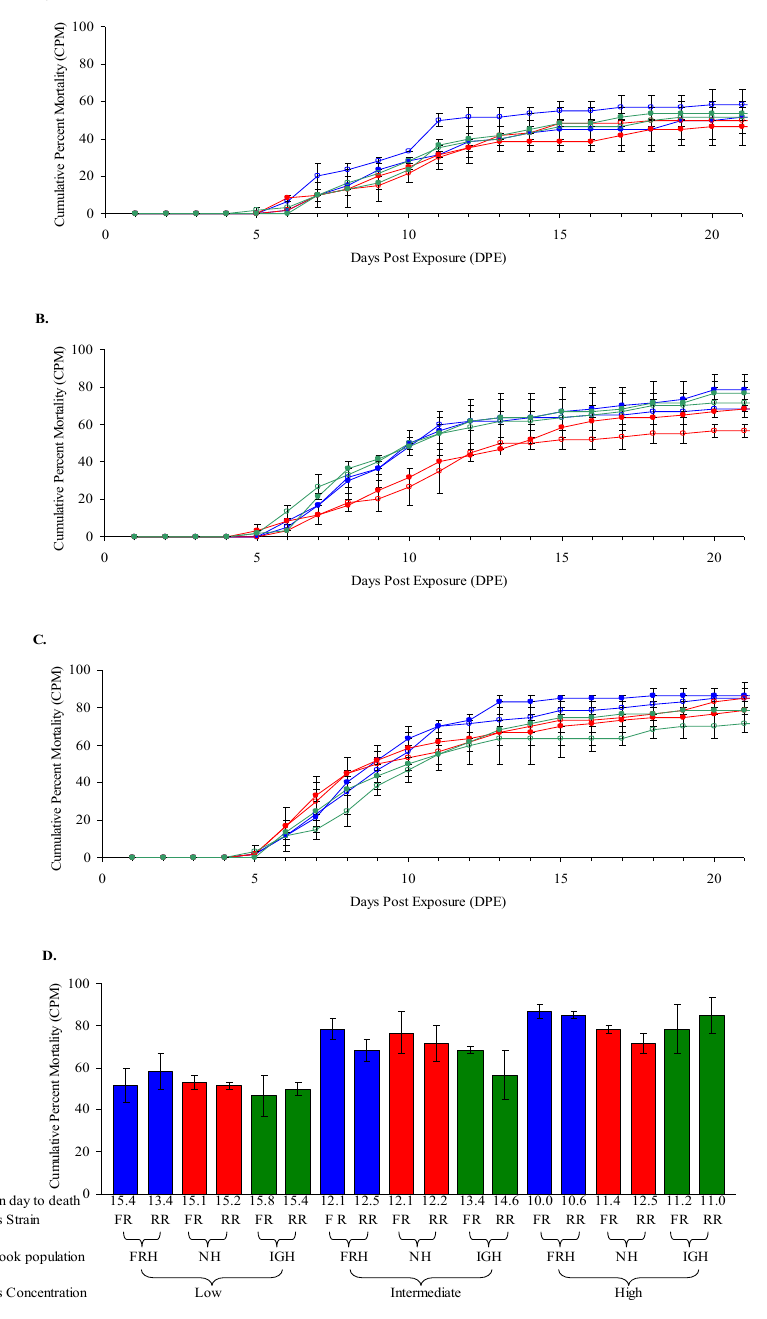
Figure 1. Mortality of Chinook salmon fry exposed to IHNV at 12 °C. Average daily cumulative percent mortality (CPM) is shown for duplicate groups of 30 Feather River Hatchery (FRH) Chinook salmon (blue), Nimbus Hatchery (NH) (red) and Iron Gate Hatchery (IGH) Chinook salmon (green) fry (0.54–0.57 g) after waterborne exposure to ( A ) low, ( B ) intermediate and ( C ) high doses of infectious hematopoietic necrosis virus subgroup LII isolate FR04 (filled symbols) or subgroup LI isolate RR98 (open symbols) at a water temperature of 12 °C. Actual exposure doses determined at the time of challenge were: RR98, 5.7 × 10 4 , 5.7 × 10 5 , and 5.7 × 10 6 pfu mL − 1 ; and FR04, 4.6 × 10 4 , 4.6 × 10 5 , and 4.6 × 10 6 pfu mL − 1 . ( D ) Bars show average CPM (±SE) in duplicate treatment groups.